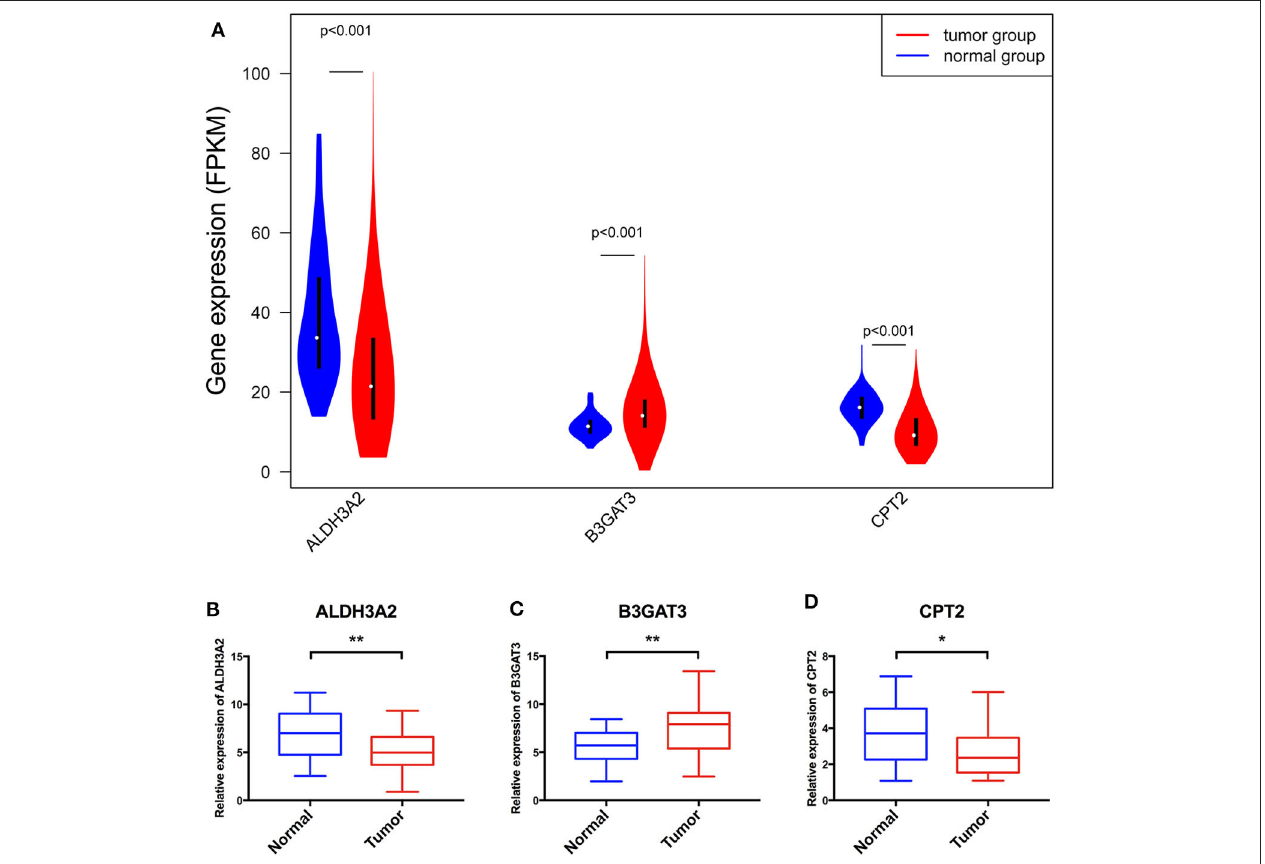
FIGURE 7 | The violin plot based on TCGA data (A) and further validation via qRT-PCR (B–D) of the three genes consisting of the RS model. *Means p < 0.05, **Means p <